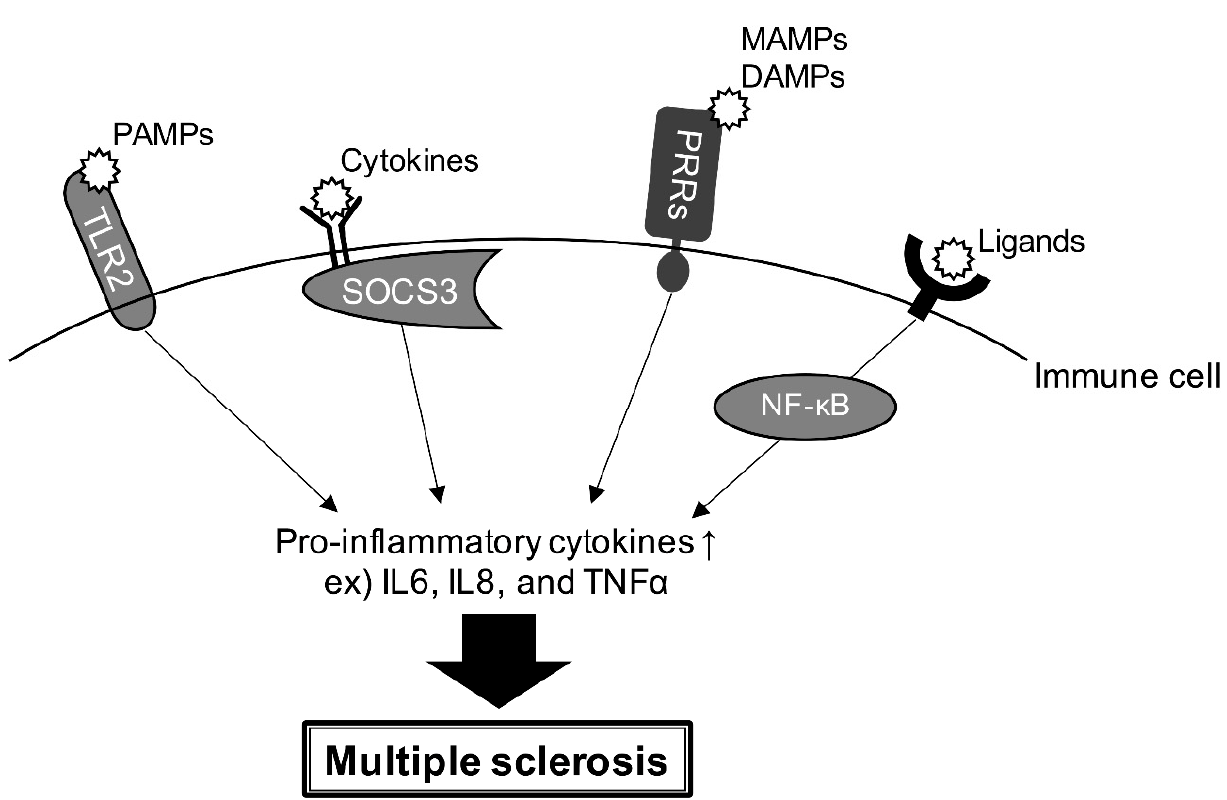
Figure 3. Interaction of some receptors with their cognate ligands induces the expression of pro- inflammatory cytokines in immune cells. Pathogen-associated molecular patterns interaction with TLRs, SOCS3 activation by cytokine receptors, microbe-associated molecular patterns or damage- associated molecular patterns binding to pattern recognition receptors, and/or activation through NF- κ B are involved in the regulation of the expression of inflammatory cytokines, which are responsible for MS, in immune cells.